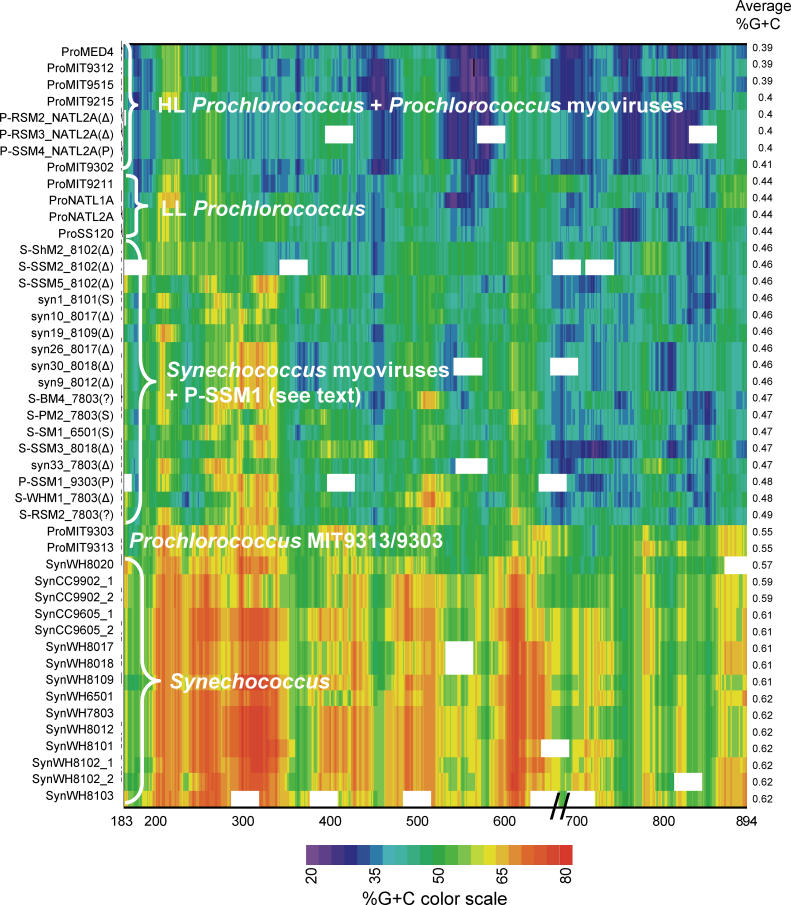
Visualization of %G+C Content across the
psbD Gene
Details as in
Figure 3. Note that the 21-nucleotide indel in
Prochlorococcus hosts and their phages [
13] (unpublished data) was excluded from the analysis at the position indicated by the “//” symbol to maximize the data that could be displayed using the sliding window approach.